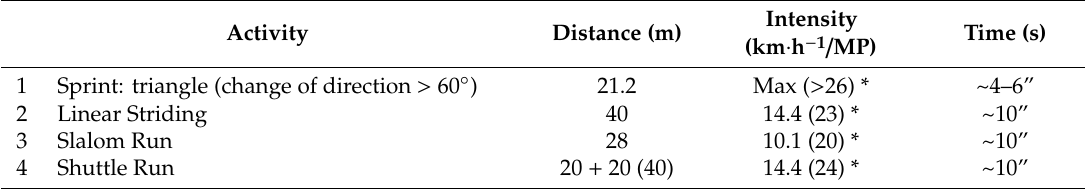
Table 1. Soccer-specific intermittent exercise protocol activities.